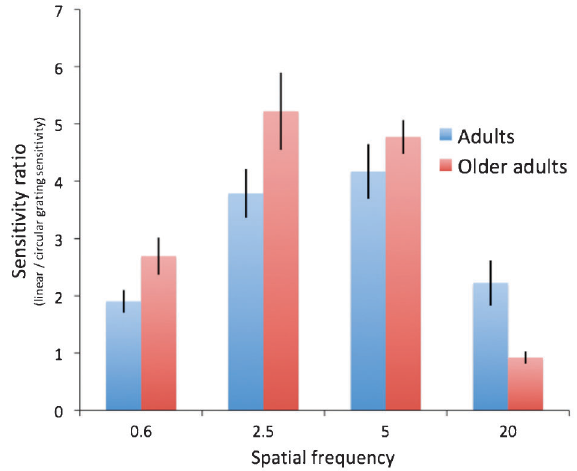
Figure 3. Sensitivity ratios of young adults (20-30 years of age) and older adults (60-70 years of age) for linear and circular gratings. Data are reported as means±SD. Values greater than one indicate that sensitivity to vertical linear was greater than for circular concentric